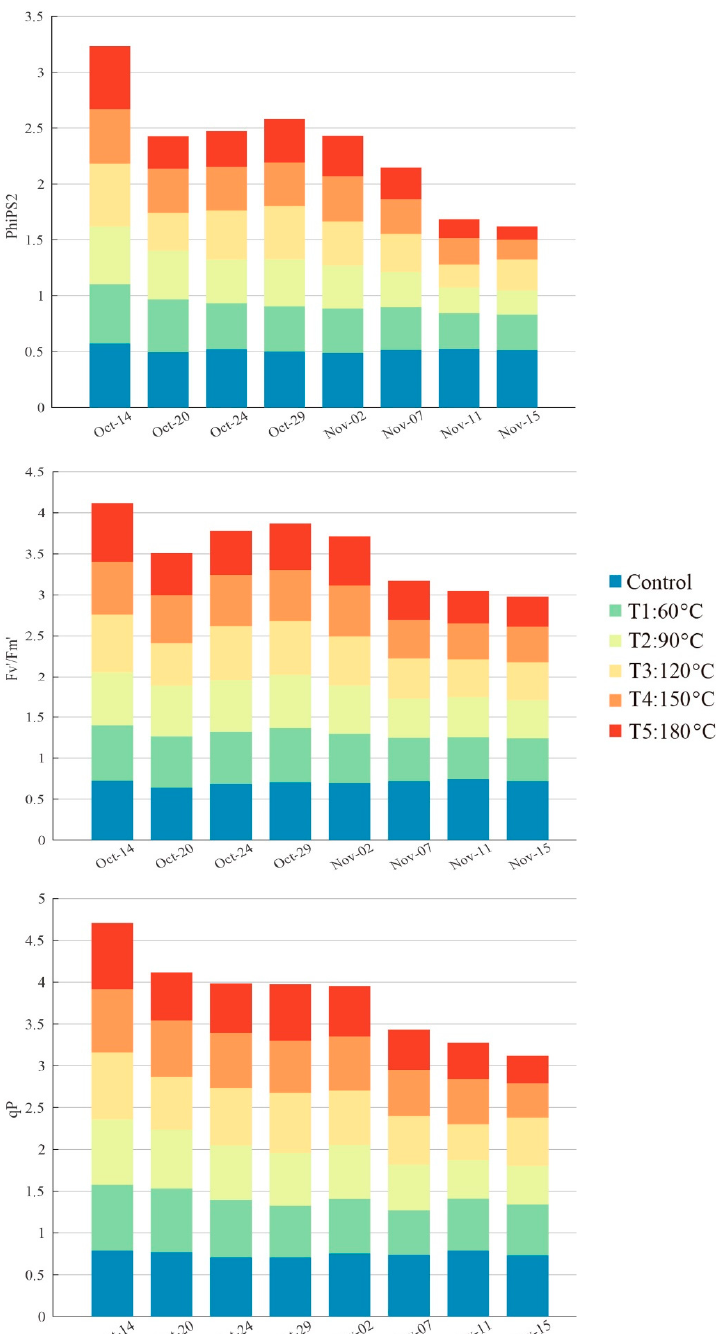
Figure 3. Time series of actual photochemical efficiency of PS II (PhiPS2), the quantum efficiency of photosystem II under light-adapted conditions ( Fv'/Fm' ), and the photochemical burst coefficient